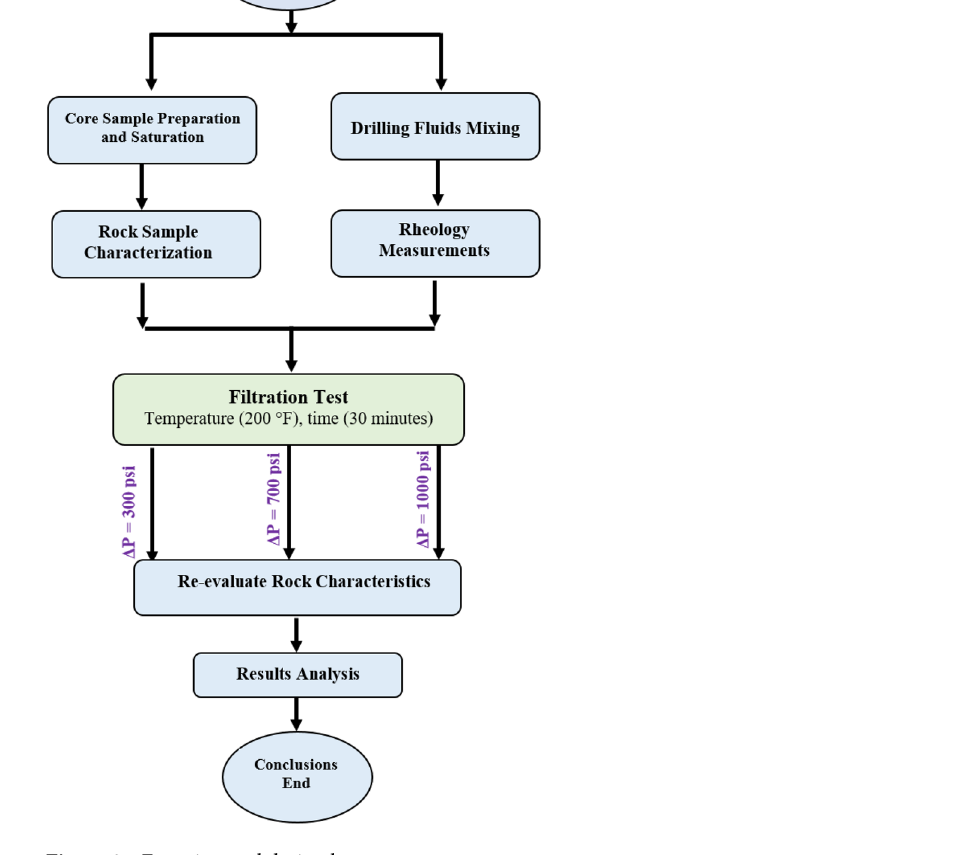
Figure 2. Experimental design